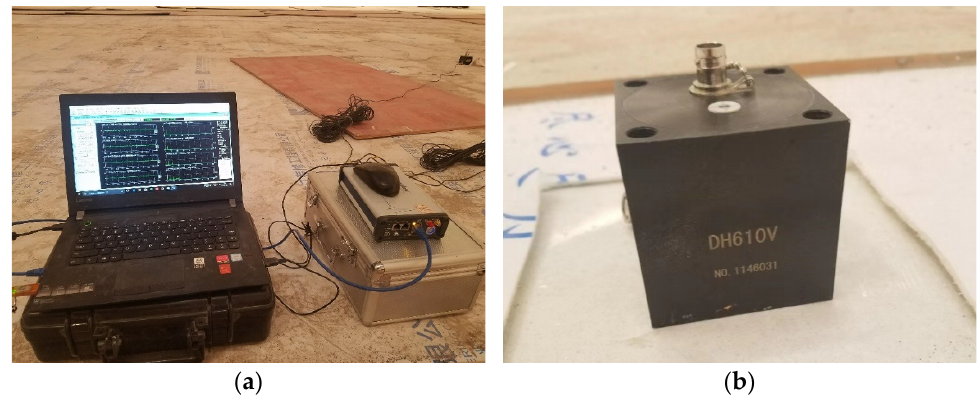
Figure 3. The schematic diagram of the test setup: ( a ) data acquisition instrument; ( b ) magnetoelectric vertical acceleration sensor.